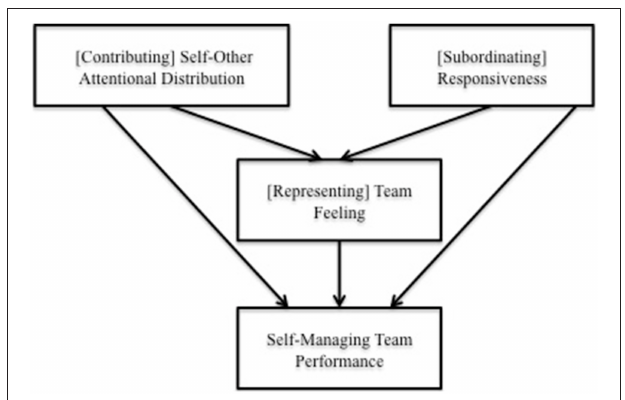
FIGURE 1 | Theorized model of relationships between operationalizations of contributing, subordinating, representing, and SMT